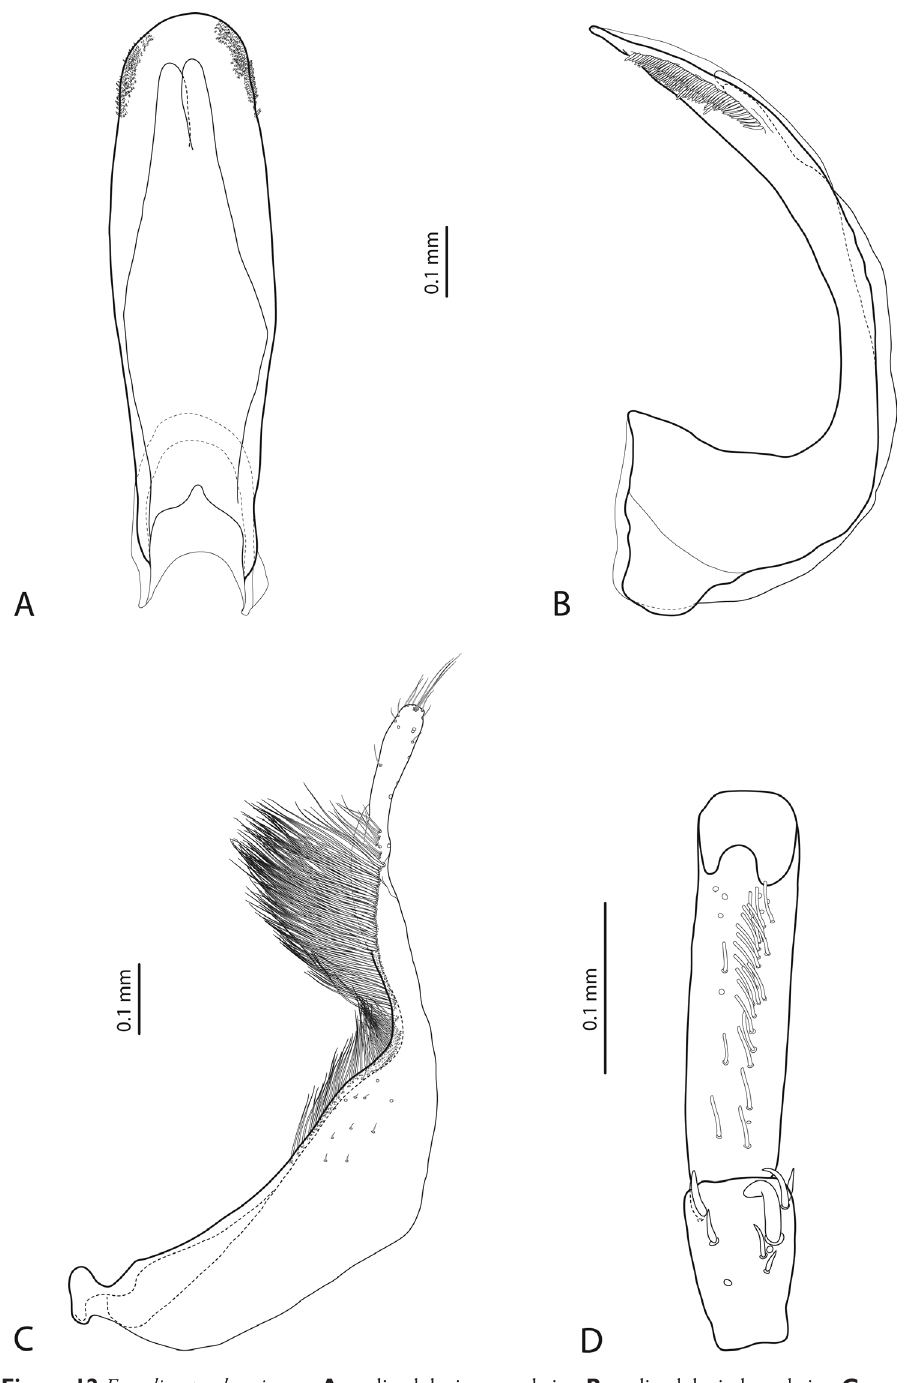
Figure 12 Exocelina tomhansi sp. n. A median lobe in ventral view B median lobe in lateral view C para- mere in external view D male protarsomeres 4–5 in ventral